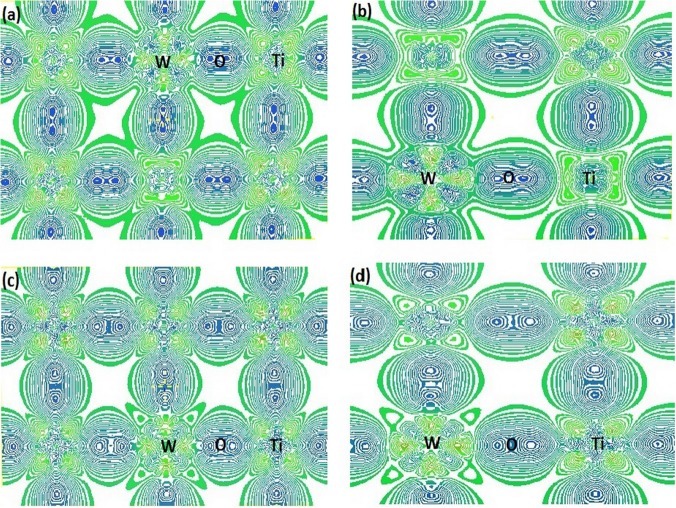
Difference charge density charts of (001) plane of the non-spin and spin for W-doped anatase TiO2.(A) non-spin Ti0.95833W0.04167O2 supercell, (B) non-spin Ti0.9375W0.0625O2 supercell, (C) spin Ti0.95833W0.04167O2 supercell, (D) spin Ti0.9375W0.0625O2 supercell.